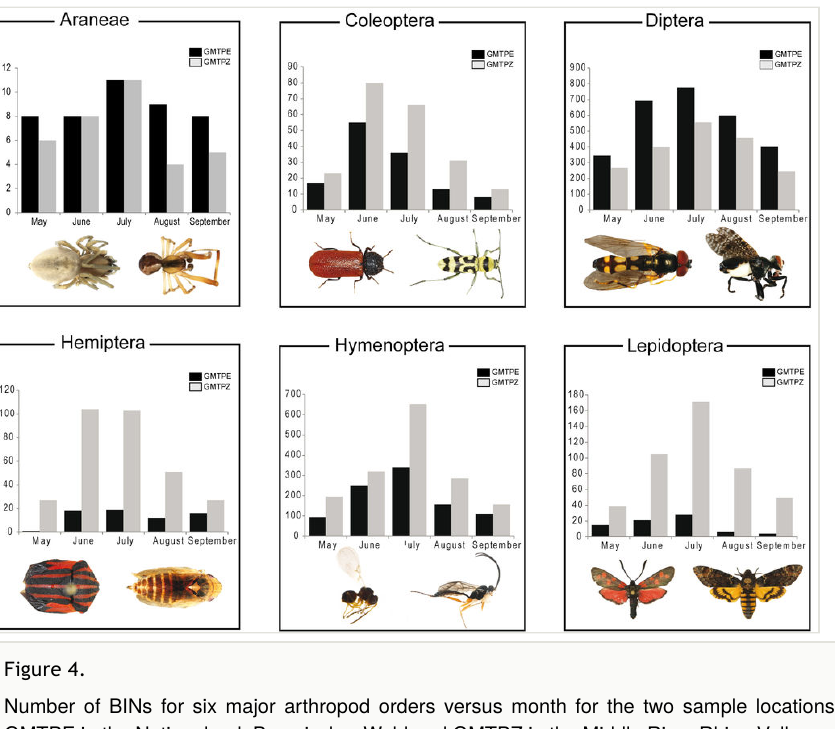
Figure 4. Number of BINs for six major arthropod orders versus month for the two sample locations, GMTPE in the Nationalpark Bayerischer Wald and GMTPZ in the Middle River Rhine